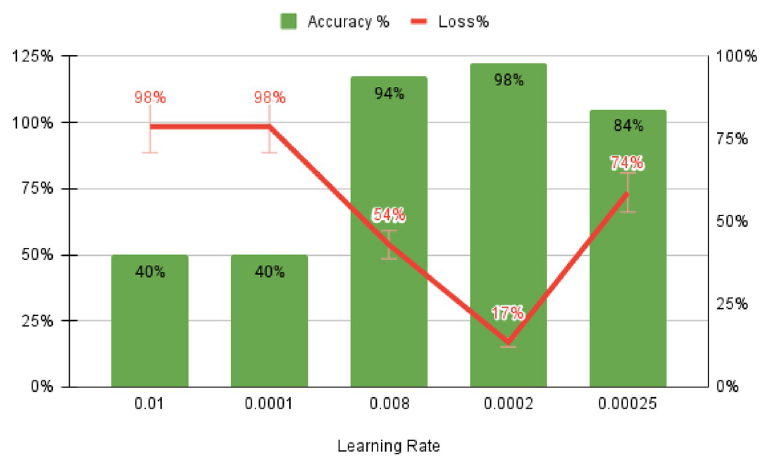
Fig 13. Accuracy as a function of the rate of